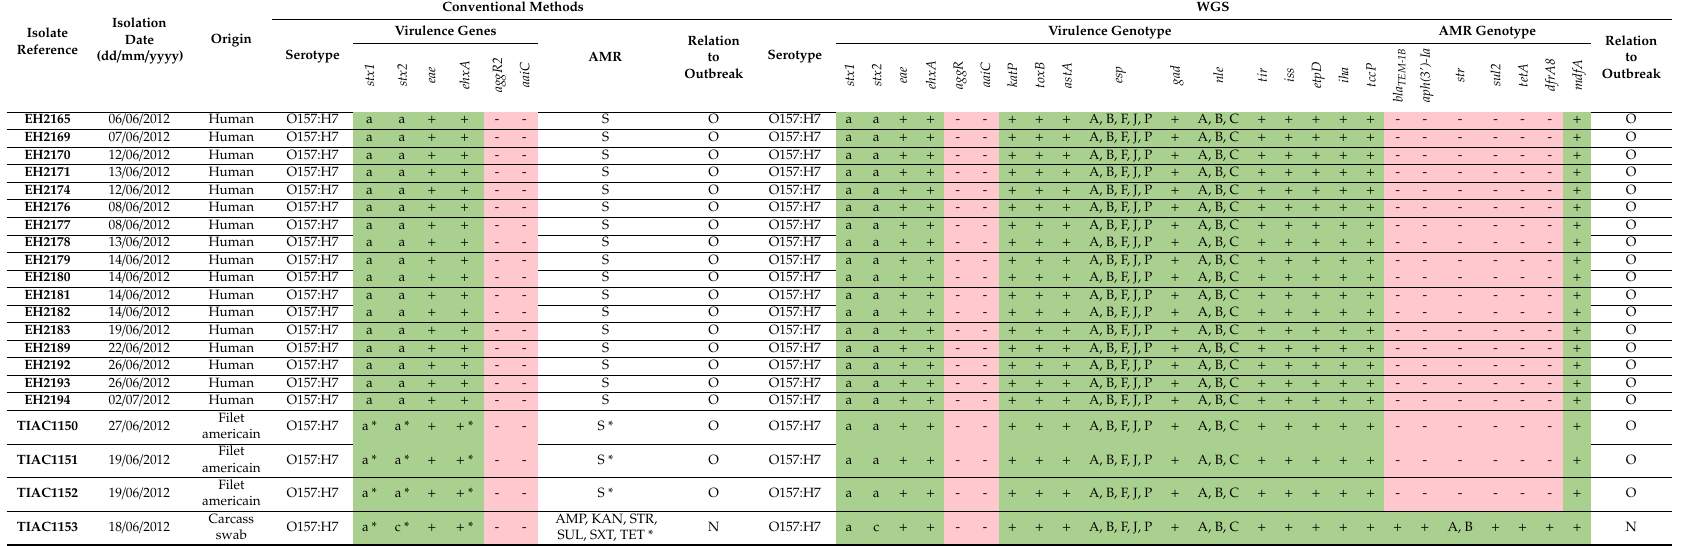
Table 1. The characteristics of, and relatedness between the Limburg 2012 outbreak isolates, determined with conventional methods and WGS data analysis. Isolate